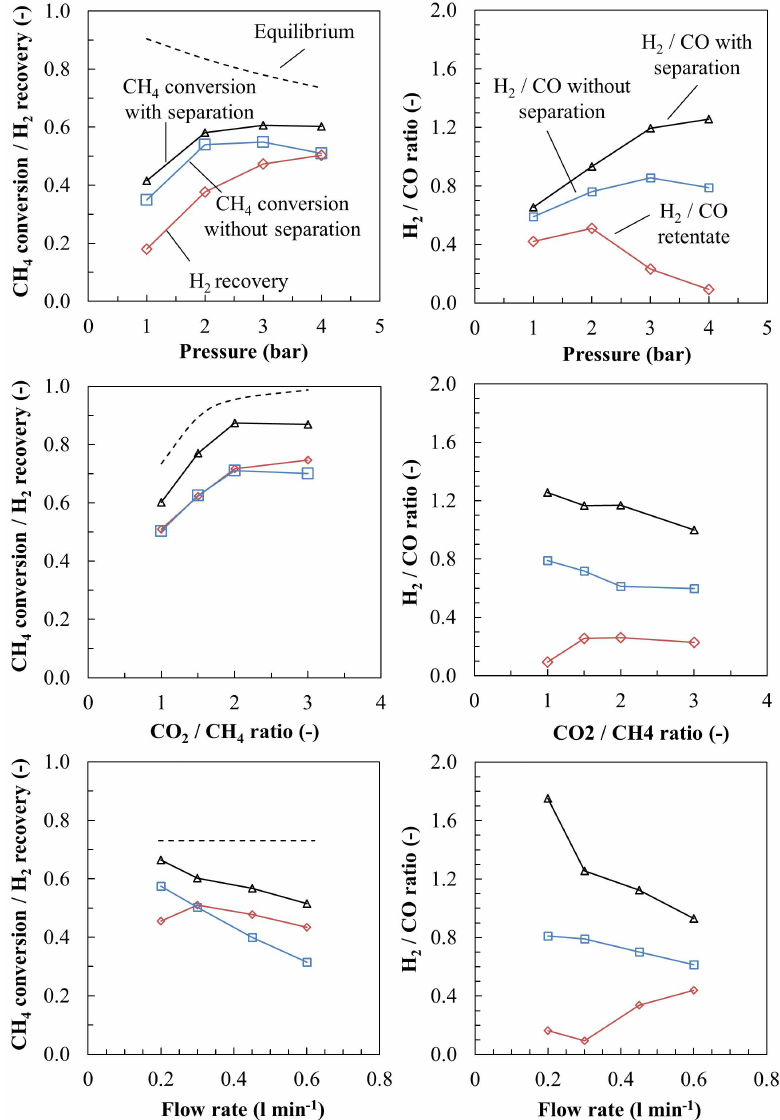
Figure 6. Parameter study for CH 4 conversion, H 2 recovery ( left column) and H 2 /CO ratio ( right column) for methane dry reforming at a process temperature of 800 ◦ C; Equilibrium conversion (dashed) calculated with Aspen plus NRTL